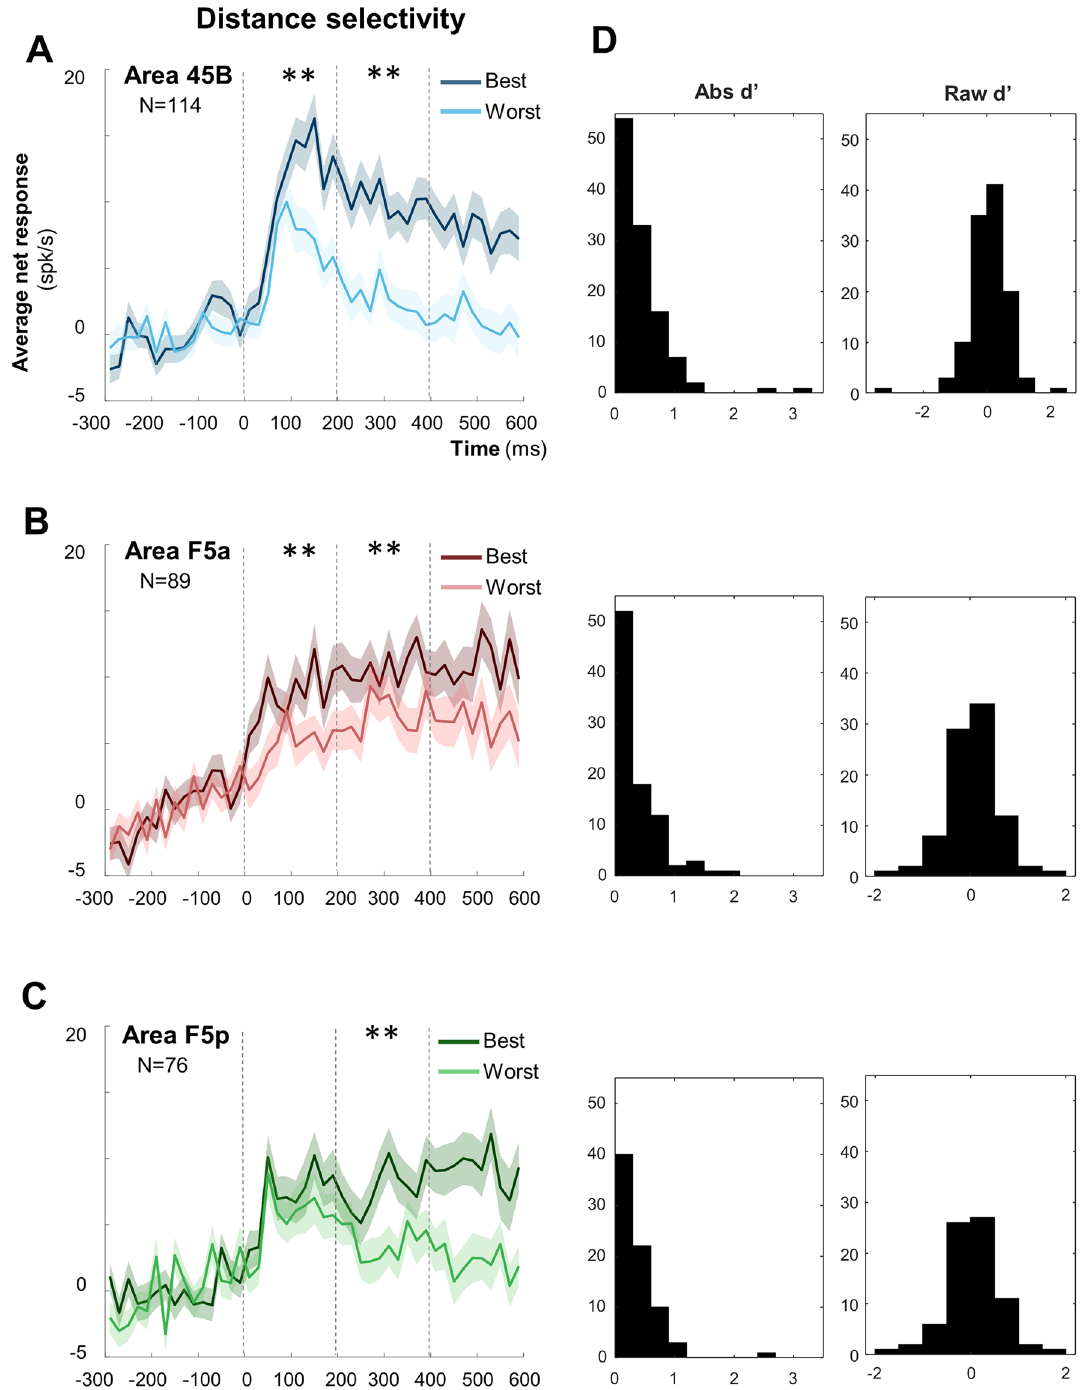
Figure 4. Distance selectivity comparing object responses at the Best and at the Worst distances. ( A )–( C ) Average distance selectivity of the even trials, previously selected on odd trials, comparing the same object at the two distances (bin size = 20 ms): darker colors represent the Best distance for the three areas (blue for 45B, red for F5a, and green for F5p); the lighter color shade indicates Worst distance. Shadows of same color represent sem. Double asterisks indicate statistical significance ( p < 0.01). See also Supplementary Fig. 2, for Monkey D and Y, separately. ( D ) absolute and raw Distance selectivity d ′ distribution for area 45B, F5a and F5p